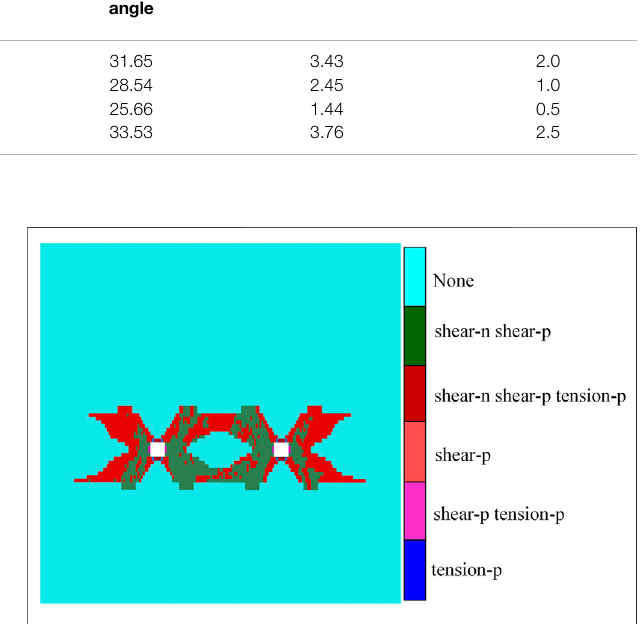
FIGURE 13 | Cloud diagram for the vertical stress distribution (Pa).